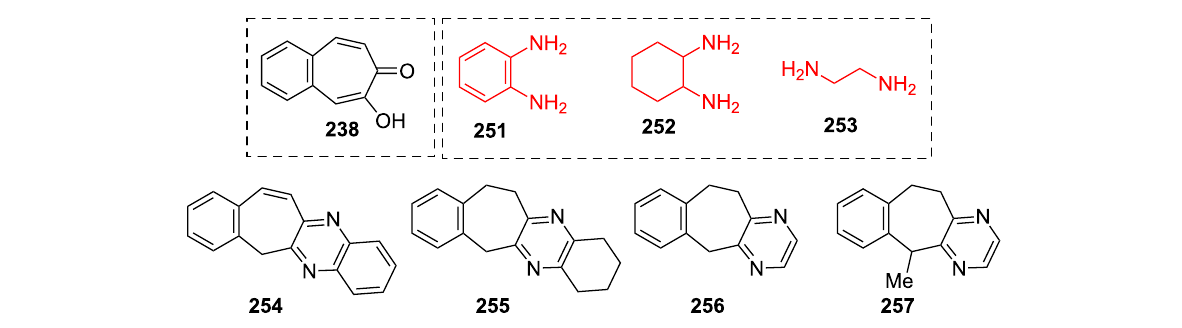
Figure 11: Some quinoxaline and pyrazine derivatives 254 – 256 prepared from 4,5-benzotropolone ( 238 ).